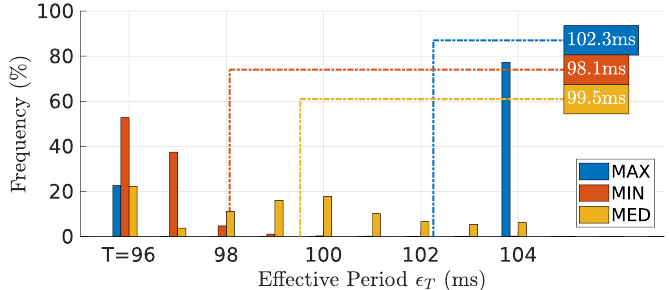
Figure 10. Distribution of the effective period observed by all the nodes. MIN results in the least variations of the effective period that remains always close to or on the round period ( T = 96